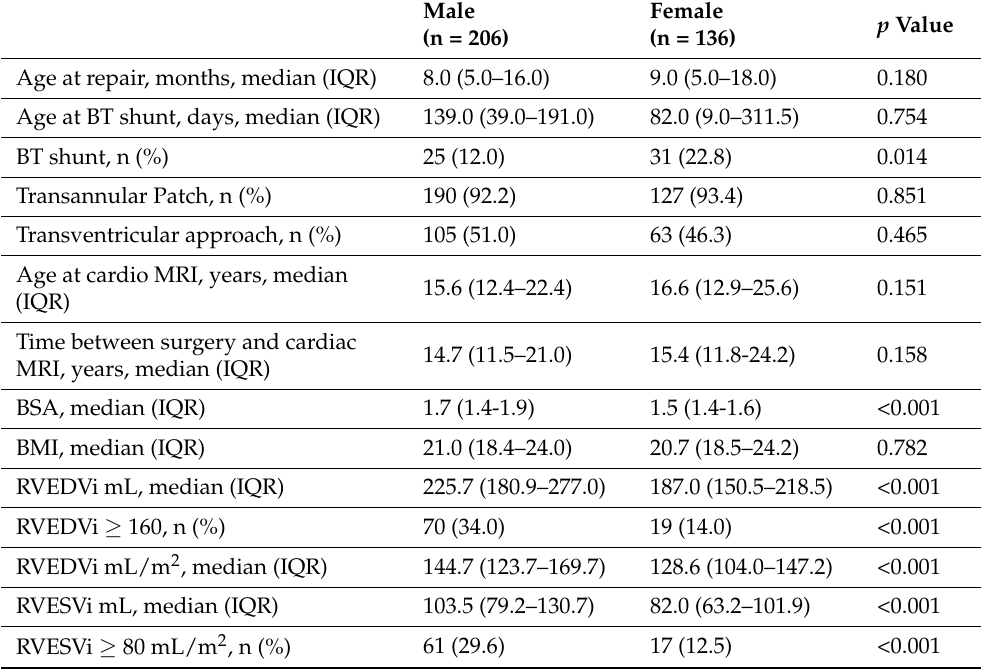
Table 2. Clinical and MRI characteristics according to gender. Legend: BT shunt = Blalock–Taussig shunt; TP = transannular patch; BSA = body surface area; BMI = body mass index; RVEDVi = right ventricular end-diastolic volume indexed by BSA; RVESVi = right ventricular end-systolic volume indexed by BSA; RVEF = right ventricular ejection fraction; LVEDVi = left ventricular end- diastolic volume indexed by BSA; LVESVi = left ventricular end-systolic volume indexed by BSA; LVEF = left ventricular ejection fraction; PR = pulmonary regurgitation fraction; RVOT = right ventricular outflow tract; PAs = pulmonary arteries; PVR = pulmonary valve replacement; NS-VT = non-sustained ventricular arrhythmias; S-VT = sustained ventricular arrhythmias; AA = Atrial arrhythmia; PMK =